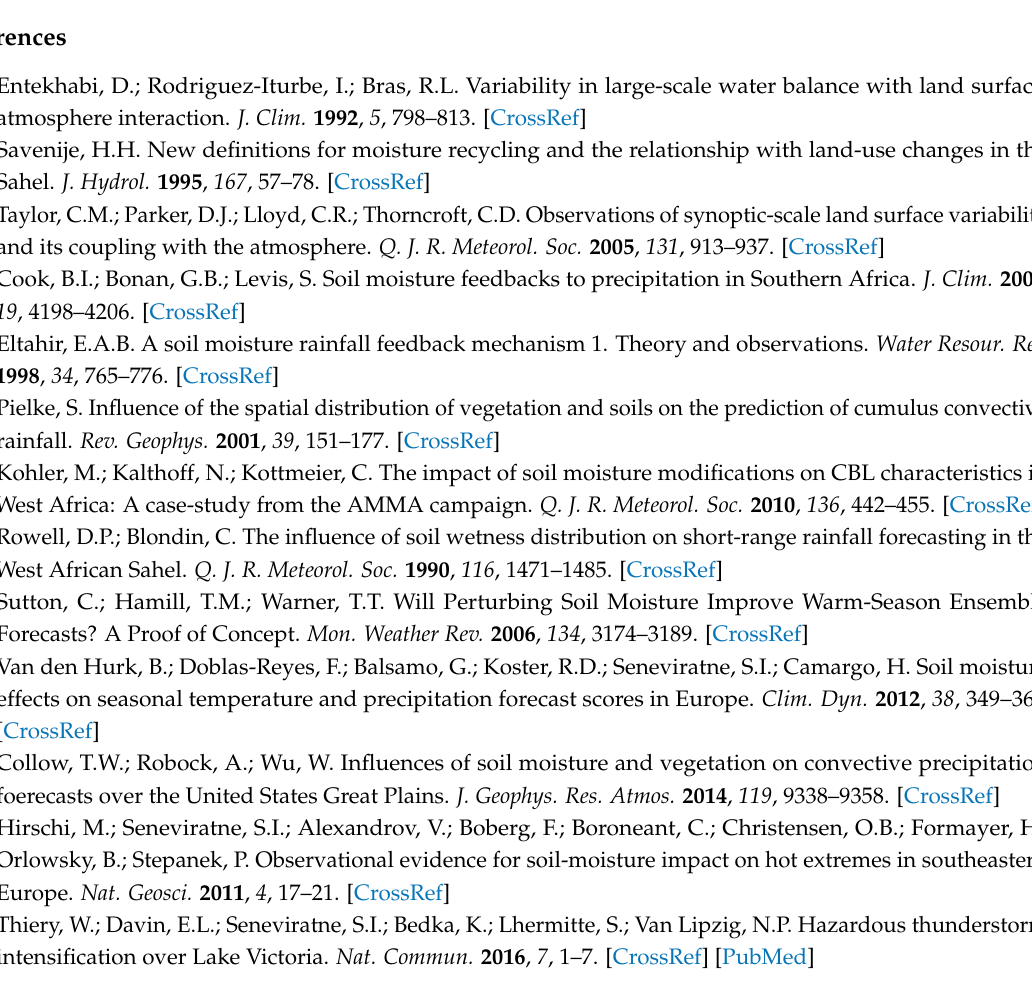
Figure A6. Same as Figure 6d–f, but for every African domain separately. Note, that pressure levels on the y -axis of LCL and BLH plots have a reverse